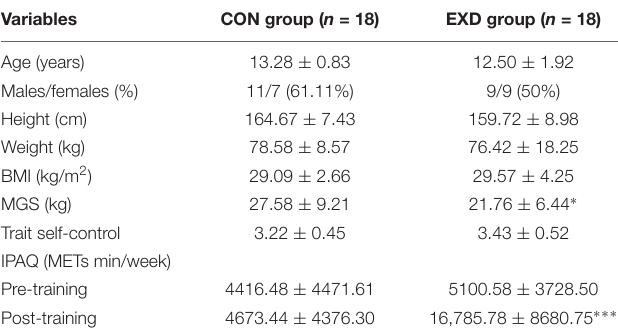
TABLE 2 | Baseline demographic characteristics of participants (mean ±